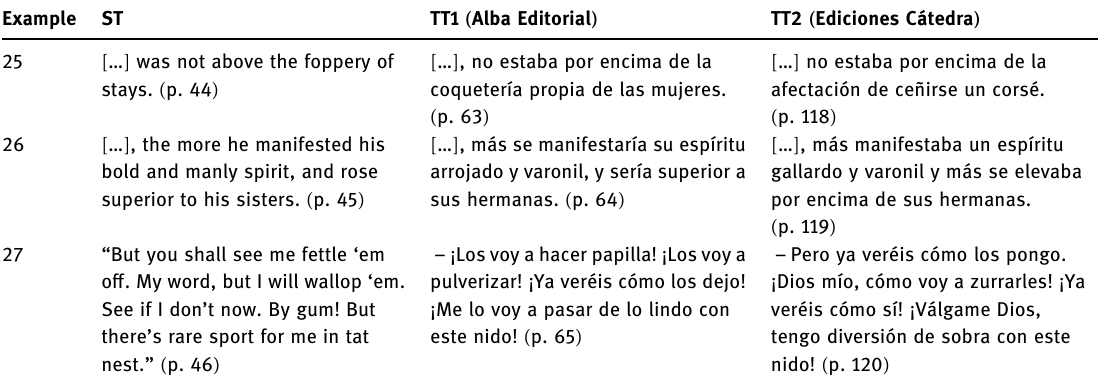
Table 5: Examples taken from Chapter